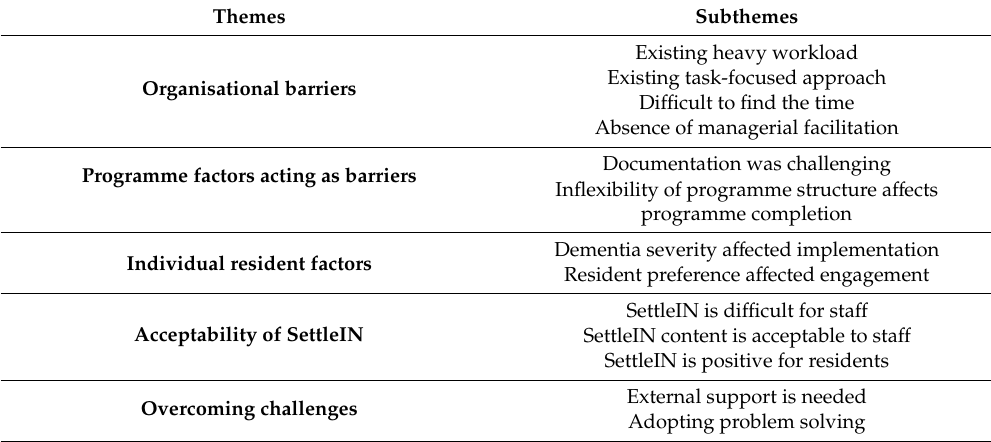
Table 8. Themes and subthemes from sta ff interview